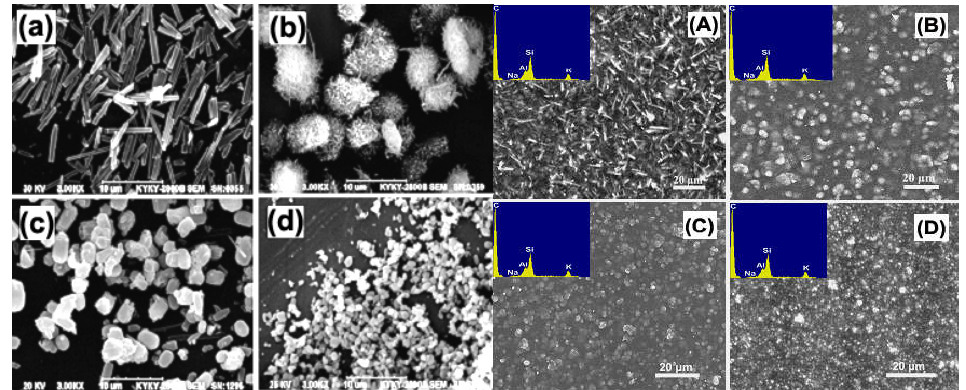
Figure 11. SEM images of zeolite T: ( a ) T-8, ( b ) T-6, ( c ) T-3, ( d ) T-0.5 and T/C hybrid membranes: ( A ) TC-8, ( B ) TC-6, ( C ) TC-3, ( D ) TC-0.5 [57].